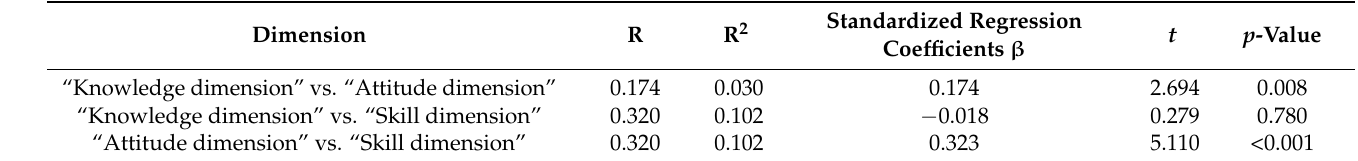
Table 4. Path analysis for EID prevention knowledge, attitudes, and skills among nurses in long-term care facilities ( N = 235).